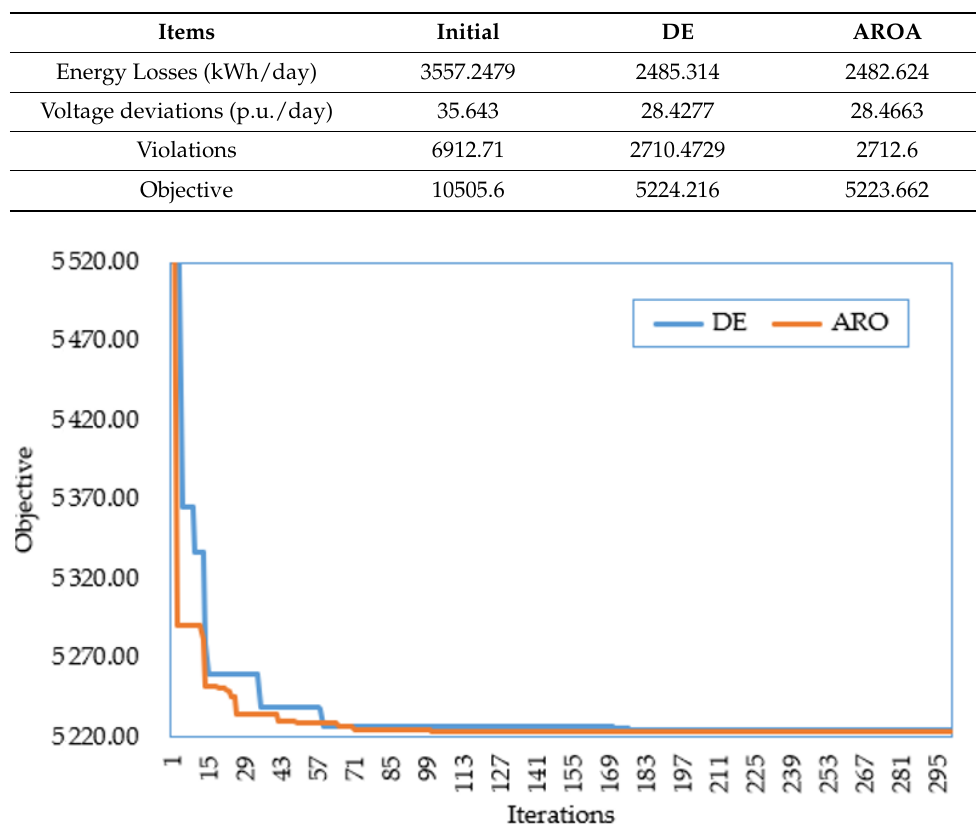
Figure 8. Convergence characteristics of DE and the AROA for the second scenario for the IEEE 33- distribution system. 33-distribution